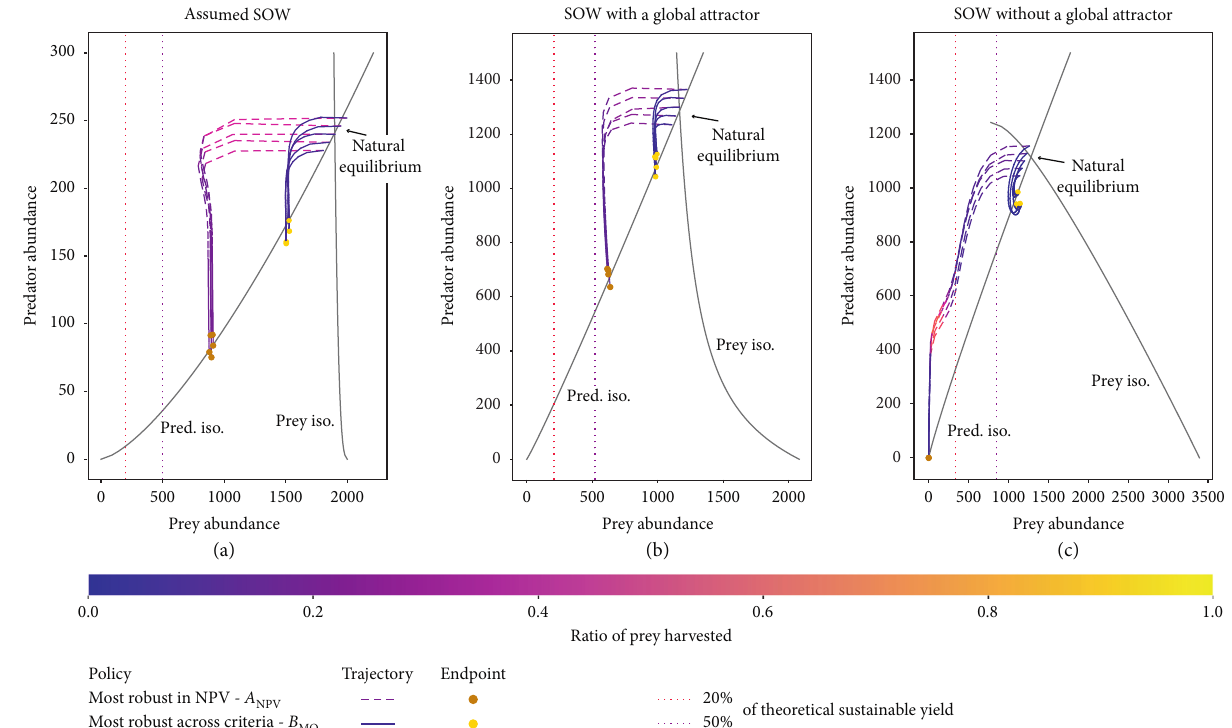
Figure 8: Fish population trajectories as a result of two harvesting policies applied in the assumed SOW and two alternative SOWs. The two and B , were identified using two robustness definitions, meeting criterion 1 and meeting all criteria, respectively. applied solutions, A NPV MO Each line is a system trajectory starting near the unharvested equilibrium. The color at each point of the trajectory indicates harvesting effort. Critical prey population levels, 50% and 20% of the biomass for theoretical sustainable yield indicate overfishing and endangerment, respectively [74, 75]. Table 2: Parameter values for the assumed SOW and four distinct SOWs. The fishery harvesting policies are optimized to the assumed SOW (in blue). The performance of the solutions in four distinct SOWs is highlighted in Figures 4–6.